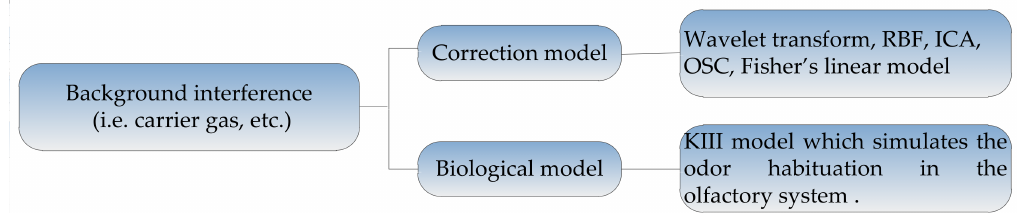
Figure 4. Methods for suppressing background